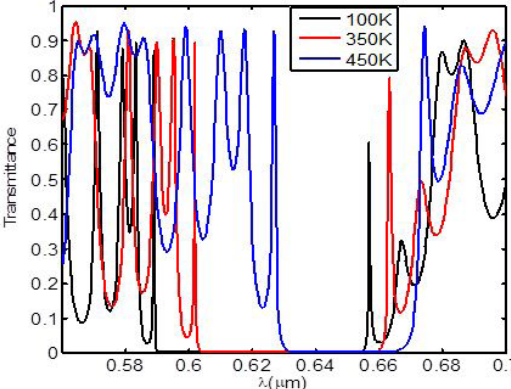
Figure 8. Transmittance spectra for quasi-periodic 1DPC at a different operating temperature with fixing the other parameters at d2=0.1µm, d3=0.08µm.